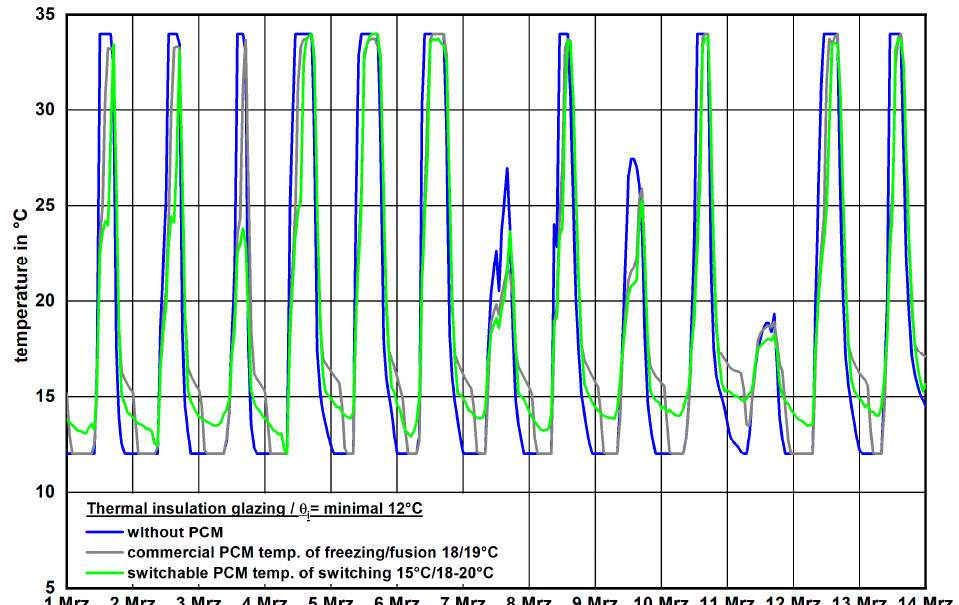
Figure 8. Comparison of the time dependence of the indoor air temperatures when using thermal insulation glazing without a PCM (blue), with a commercially available PCM (gray), and with a newly developed, programmable PCM (green), which is activated at an outdoor air temperature of 15 °C. Table 3. Required heating energy to achieve a minimum temperature of 12 °C in the greenhouse.